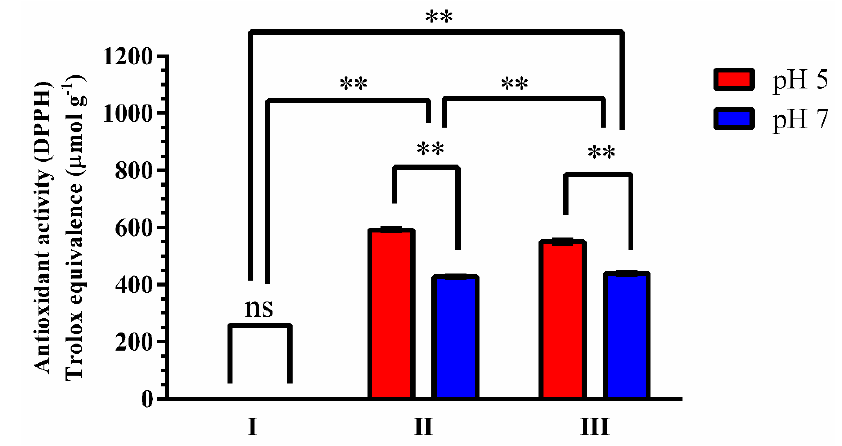
Figure 3. In vitro antioxidant activity of formulations containing grape pomace extract at pH values 5 and 7 ( n = 3). I—base and UV filters; II—base and grape pomace; III—base, UV filters and grape pomace. The results were evaluated according to the statistical two-way ANOVA: pH ( p < 0.001), concentration ( p < 0.0001). Post hoc test Sidak. ** = significant ( p < 0.001), and ns = not significant ( p <0 .001).